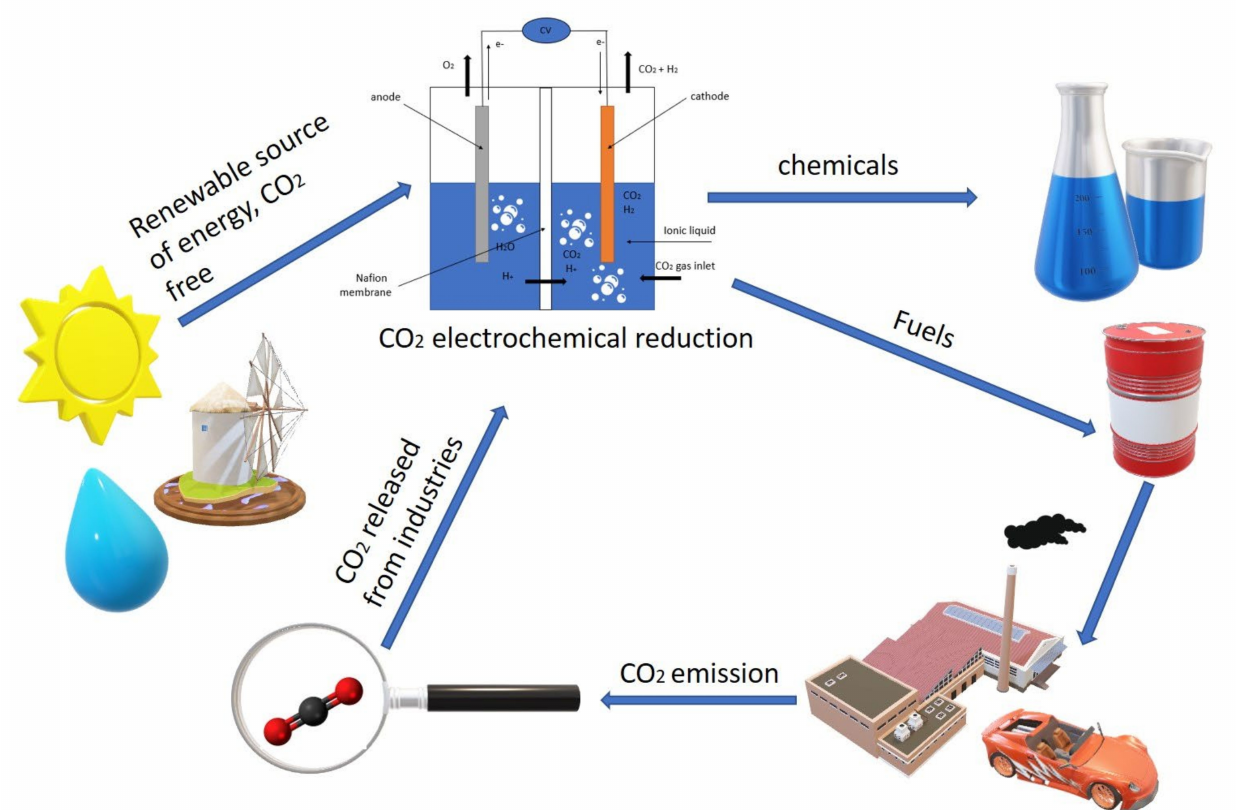
Figure 1. Carbon dioxide reduction cycle using renewable and green source of